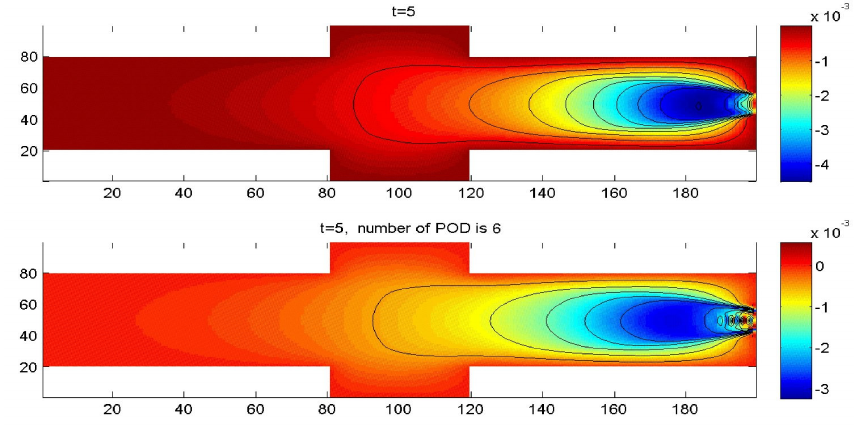
Figure 8. Top chart is the classical SCNMFE solution of velocity u and bottom chart is the POD-based reduced-order SCNMFE solution of velocity u with 6 POD bases when Re = 1000 and Pr = 7 at time t = 5.